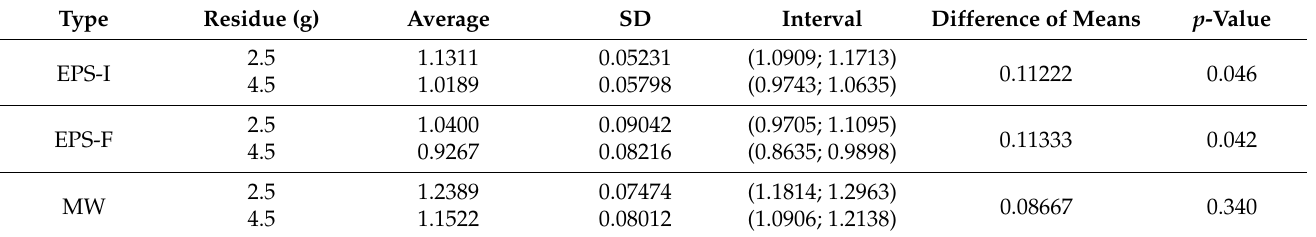
Table 18. Comparison for thermal conductivity (W/mK) between mortars with incorporation of the different thermal insulation materials.